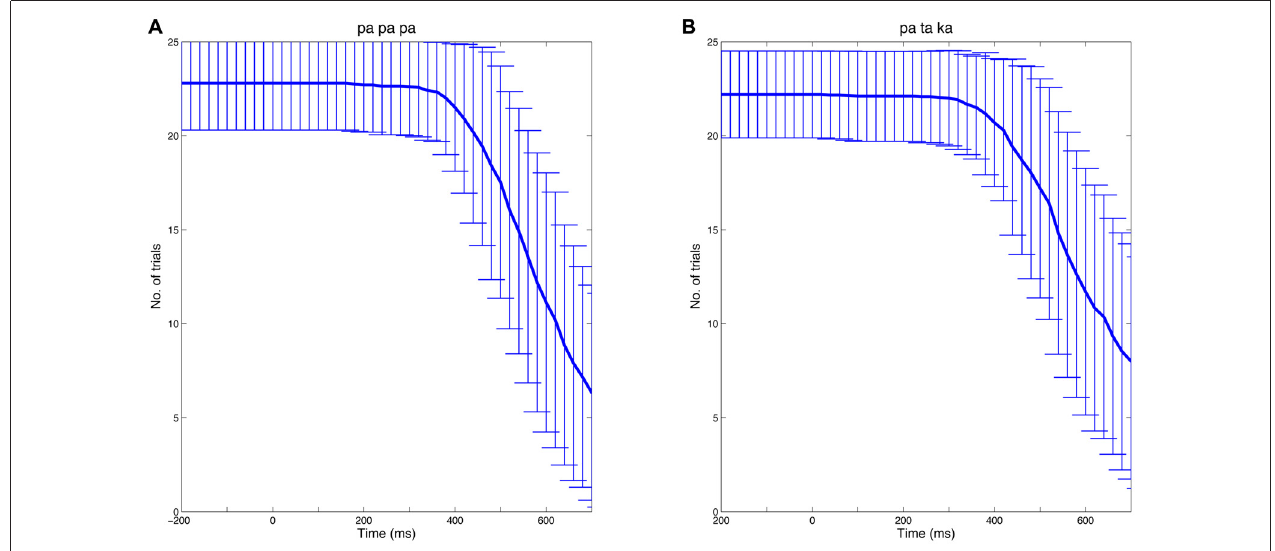
FIGURE 2 | Number of trials over time. The analysis of EEG data focused on the preparatory phase of speech production. Thus, individual EEG epochs were truncated at speech onset. The Figure shows the mean number of trials at a given time (bold blue line) for the papapa condition (A) and the pataka condition (B) across all participants. The error bars represent the standard